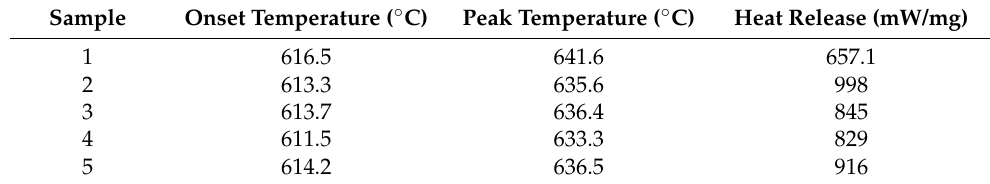
Table 6. The parameters of ball-milled B/NC/CuO